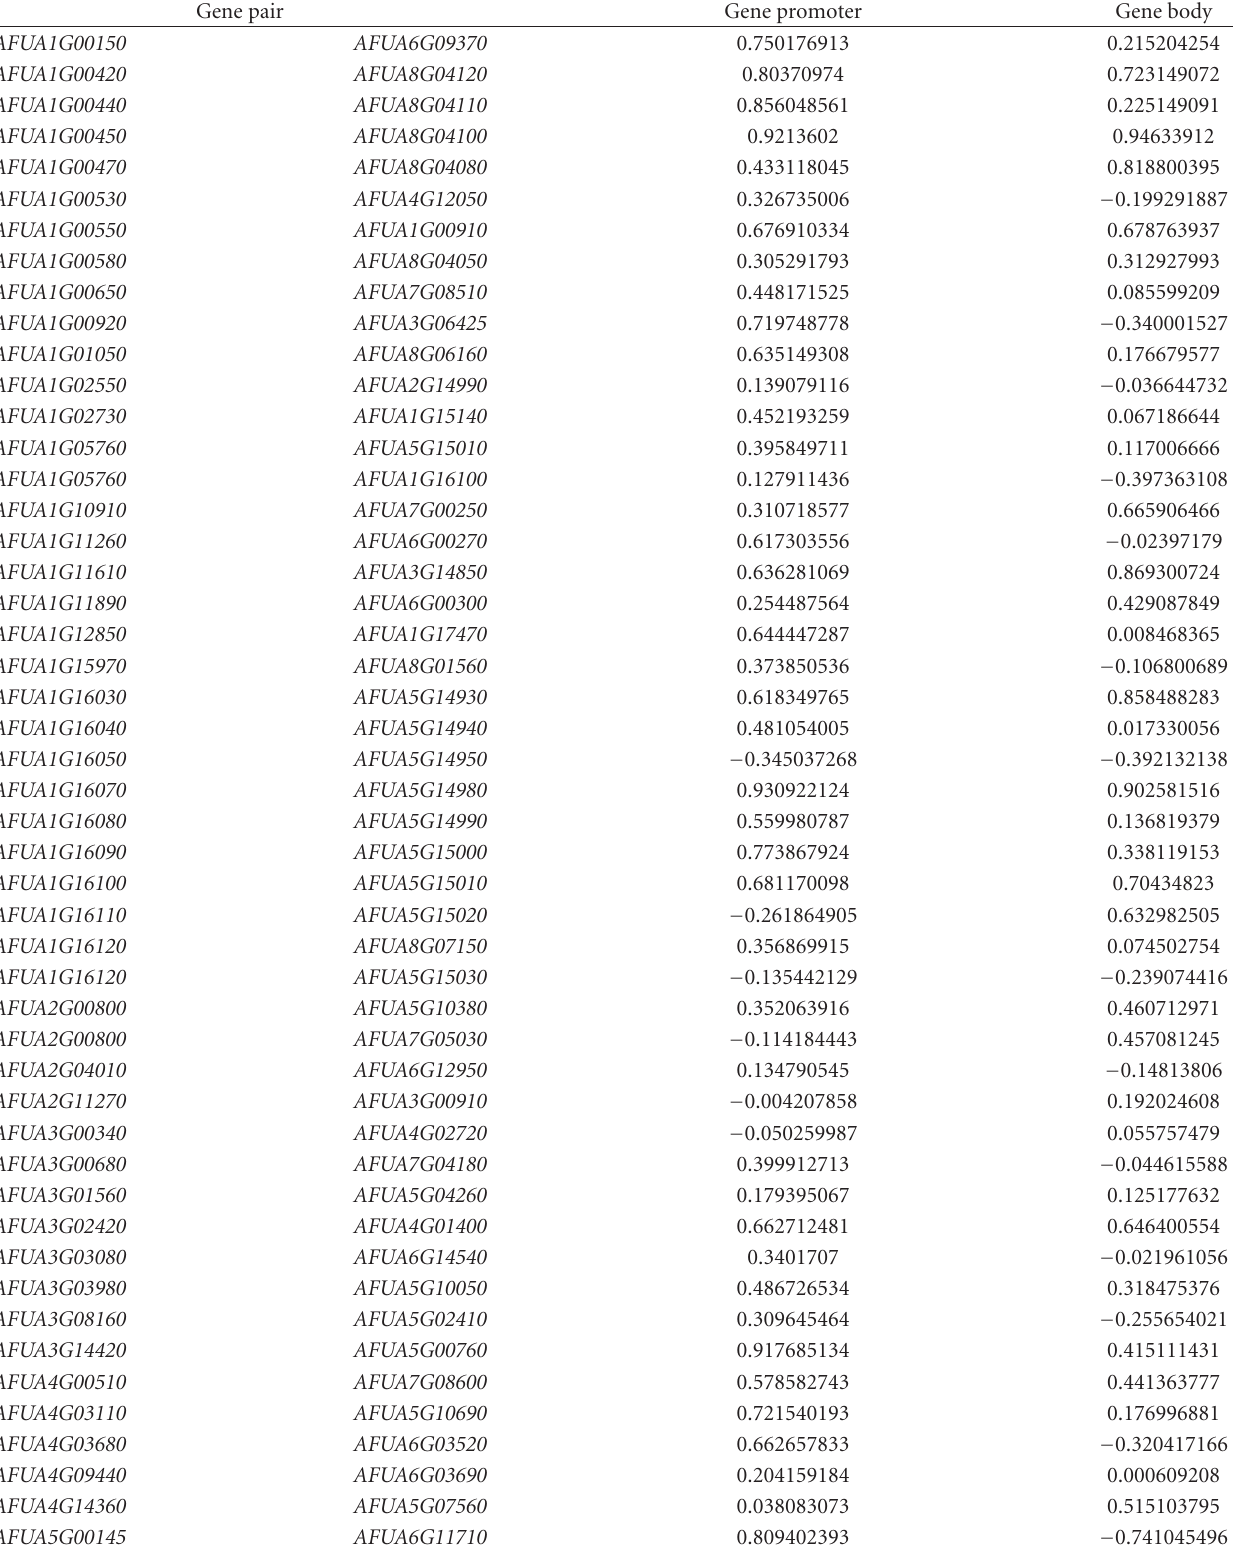
Table 2: Spearman’s rank correlation coe ffi cients of nucleosome position profiles in the promoter and body regions of 63 duplicated gene pairs in Aspergillus fumigatus